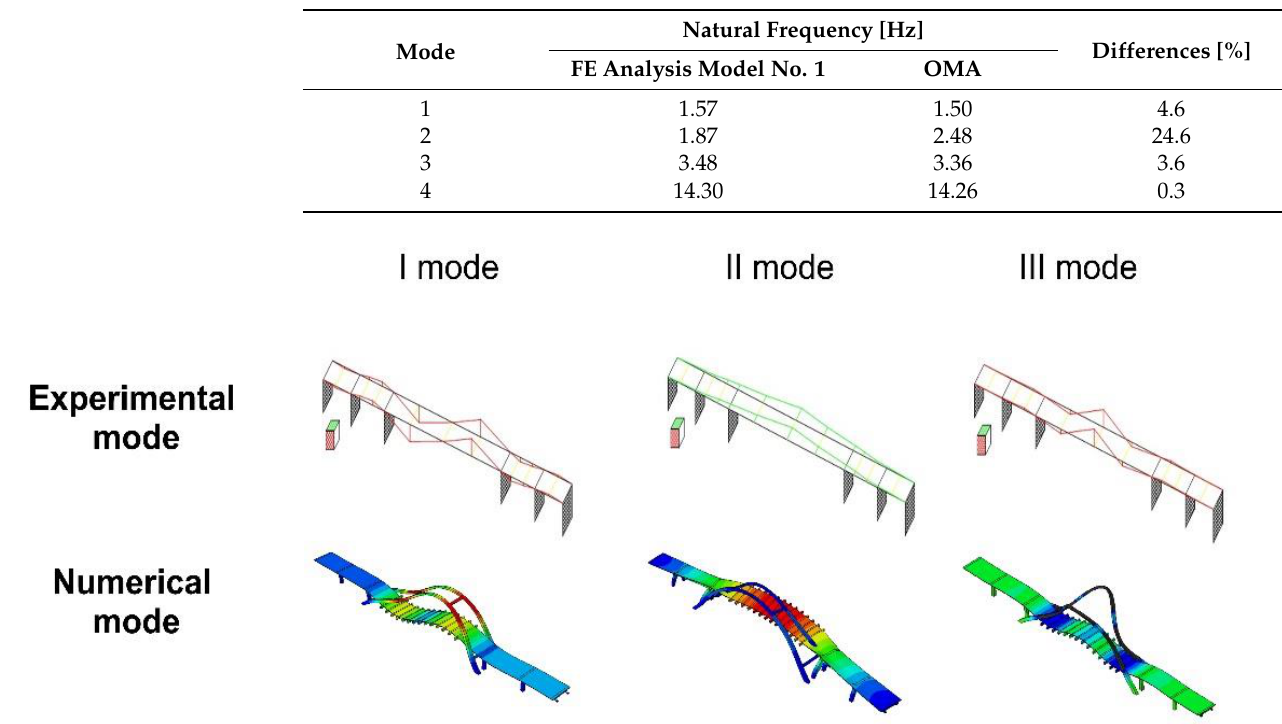
Table 2. Comparison of experimental and numerical values of natural frequencies.